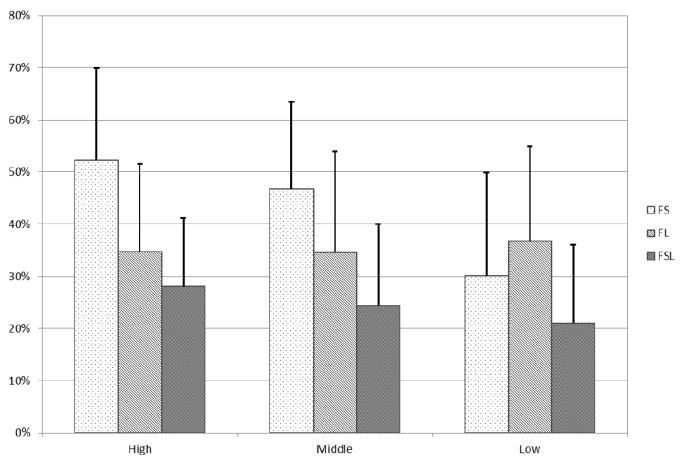
Figure 3. Histogram of the influence of the exclusion criteria on the h-values in sub-cohorts based on the starting h from Scopus.